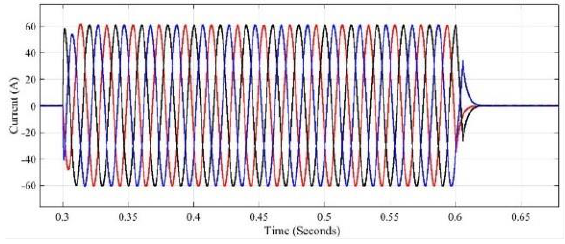
Fig.15 Current reading observed during the fault condition